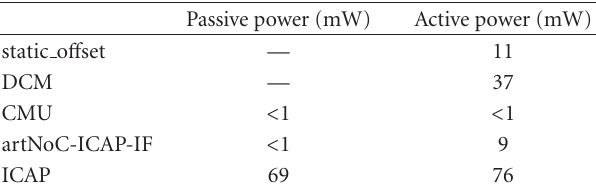
Table 2: Component power